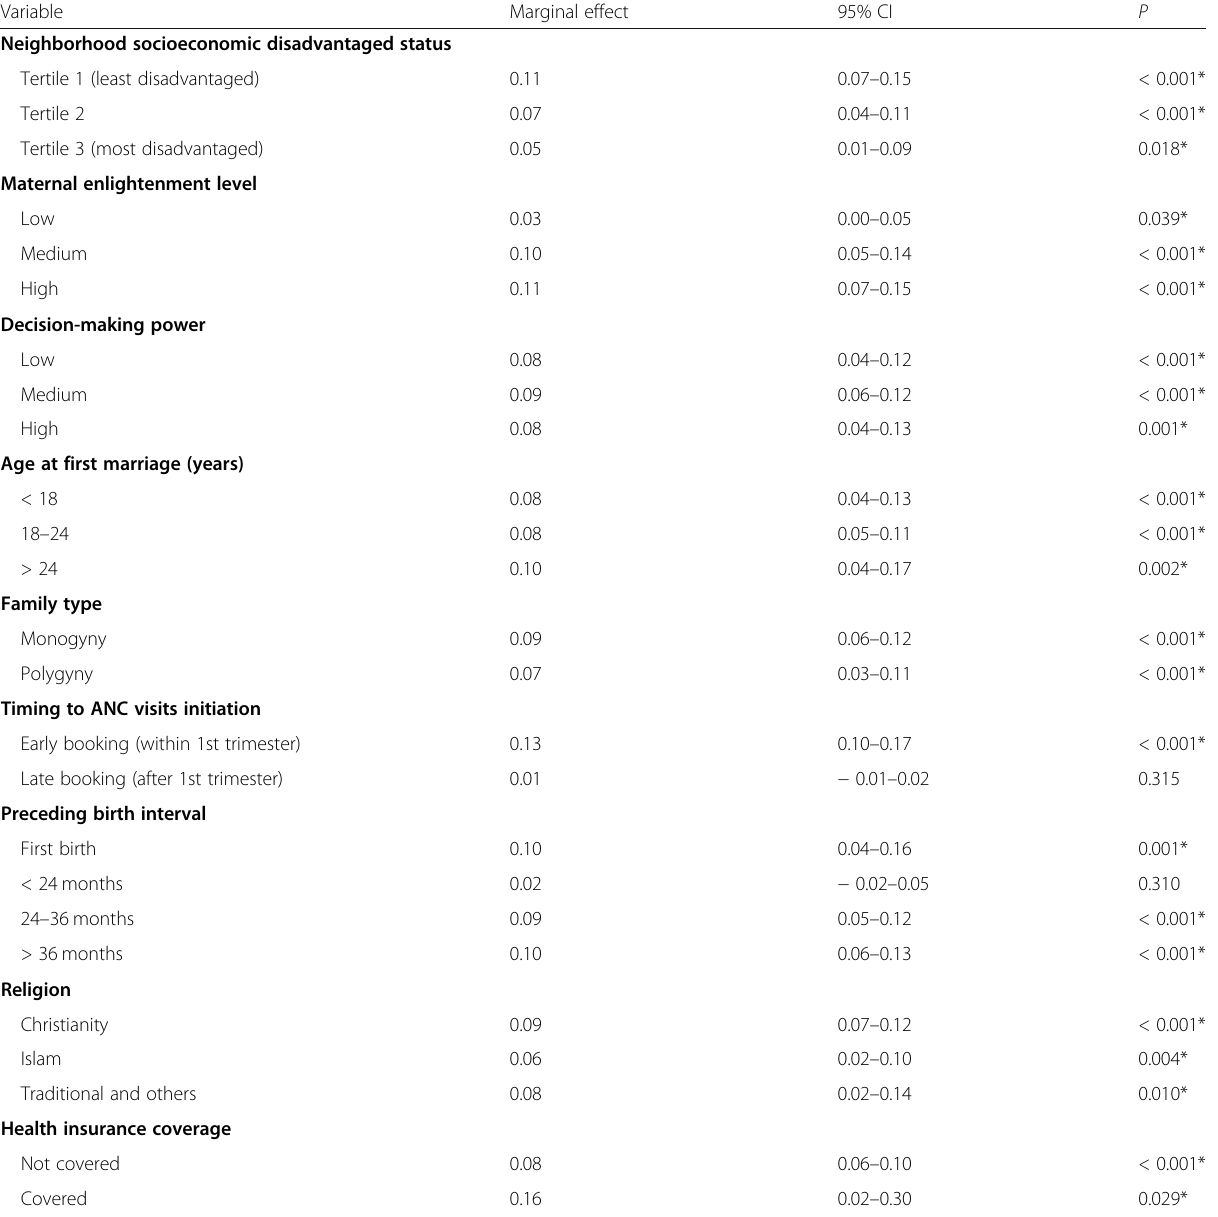
Table 3 Marginal effect of the factors associated with the frequency of ANC visits among women of reproductive age in Benin, West Africa, BDHS 2017 –